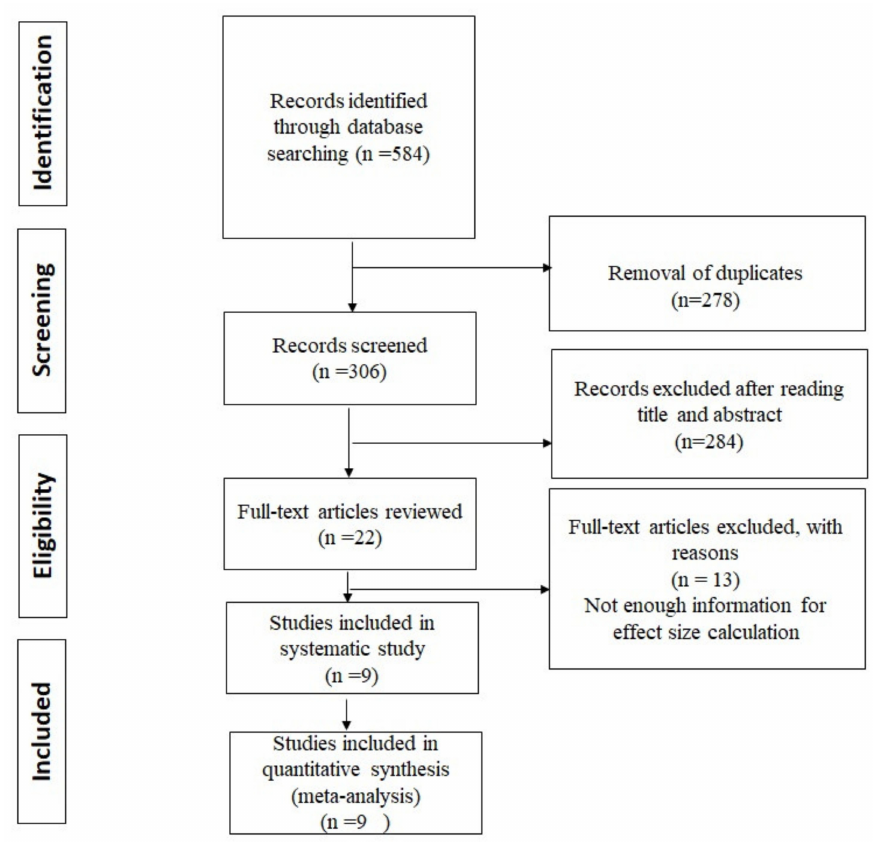
Figure 1. Preferred Reporting Items for Systematic Reviews and Meta-Analysis (PRISMA) Flowchart of the literature search of the included